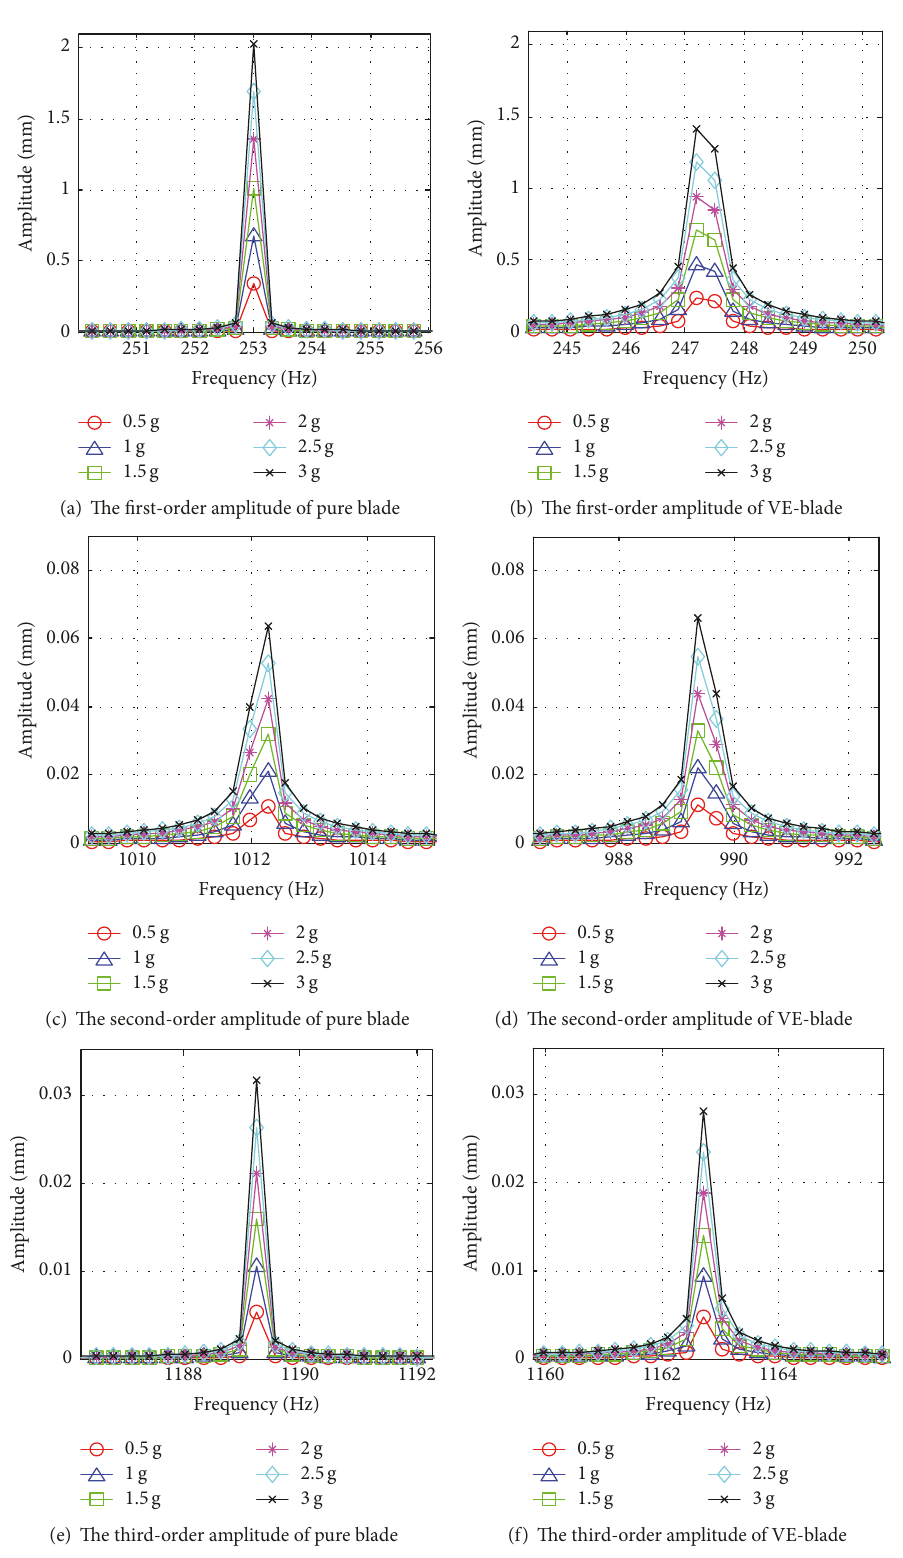
Figure 5: Comparison of numerical results of resonance characteristics of the VE-blade and pure